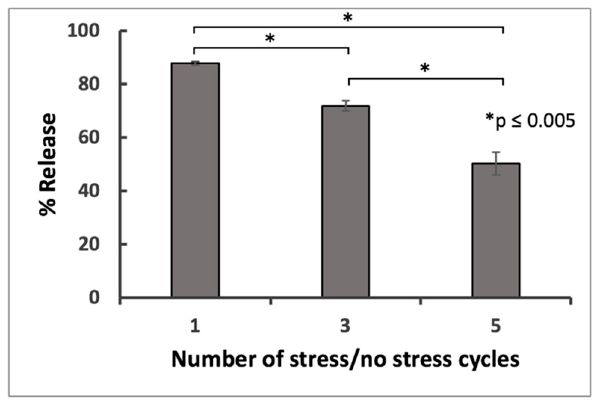
Figure 8. Impact of the number of stress/no stress cycles on the drug release rates from TXGs.